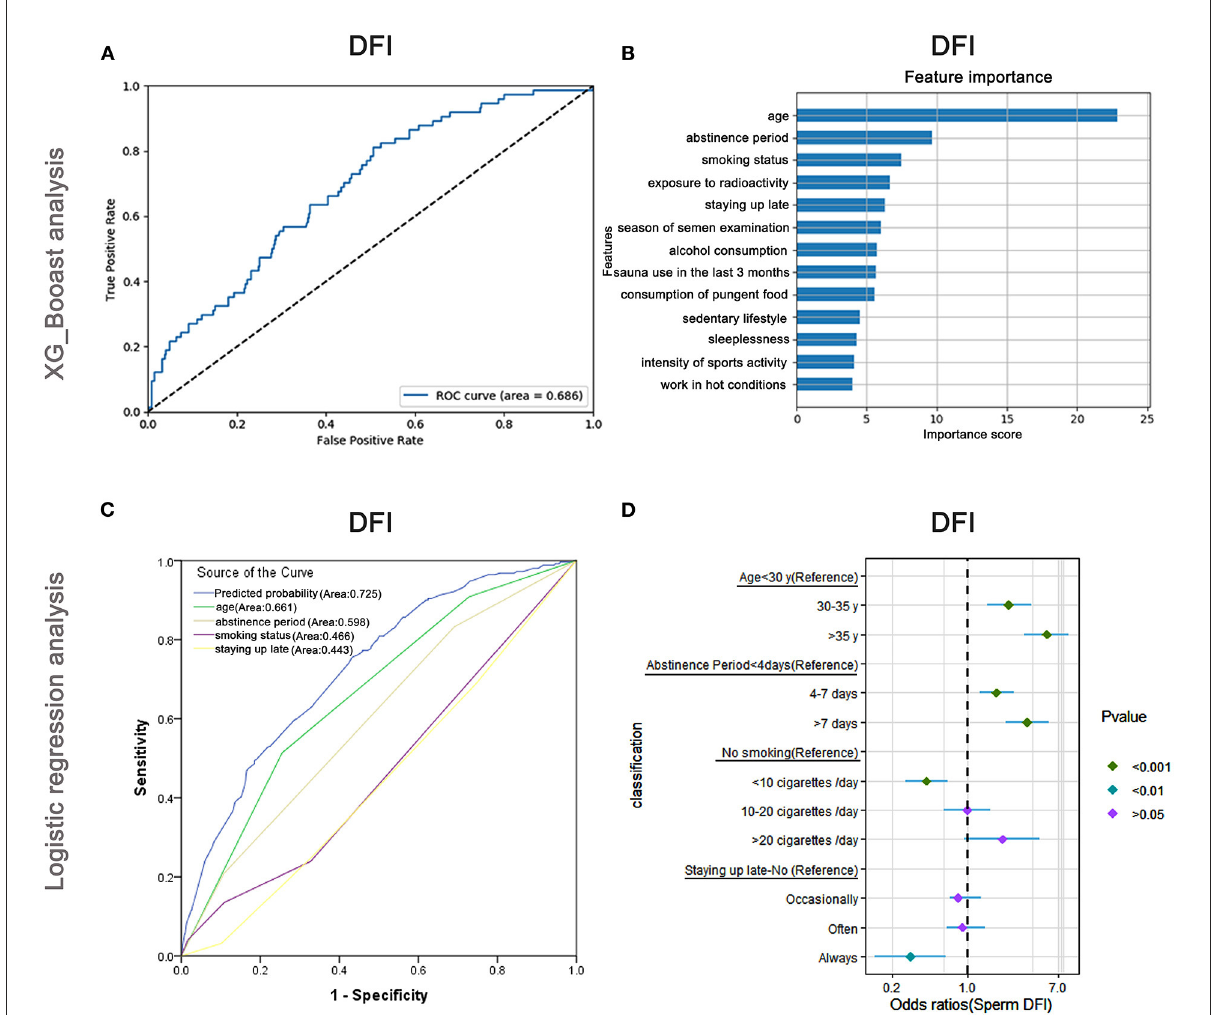
FIGURE8 XGBoost and logistic regression analysis of the risk factors for the DNA fragmentation index (DFI). The ROC curve (A) and feature importance (B) analyzed by XGBoost and the ROC curve (C) and forest diagram showing significant risk factors (D) analyzed by logistic